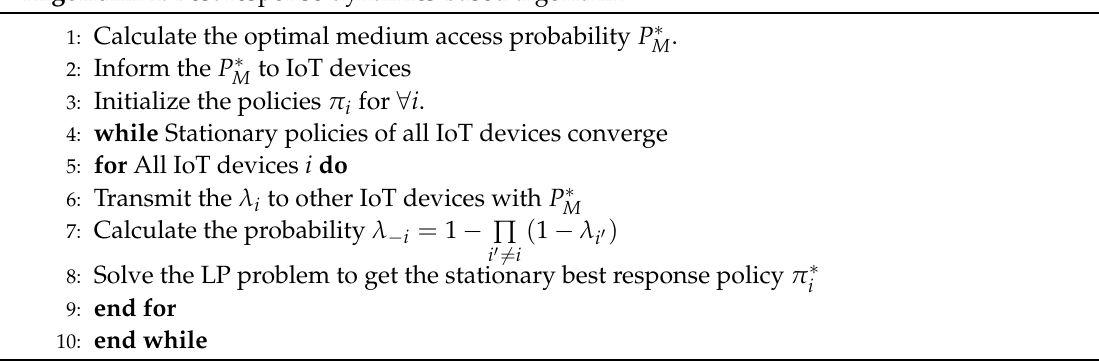
Algorithm 1: Best response dynamics-based